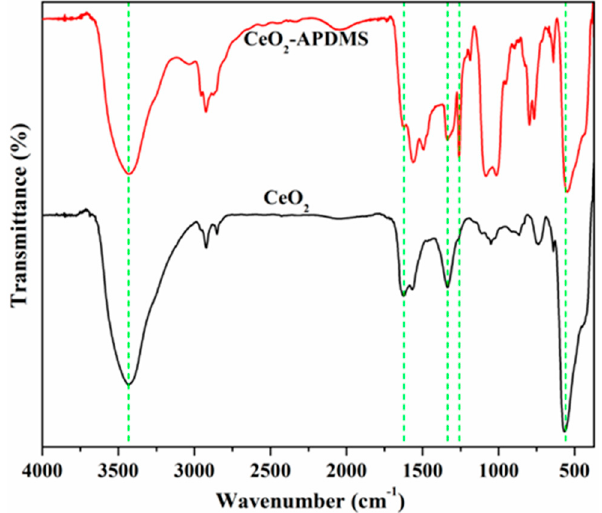
Figure 2. Fourier transform infrared (FTIR) spectra of CeO 2 nanoparticles before (black) and after (red) silane functionalization.